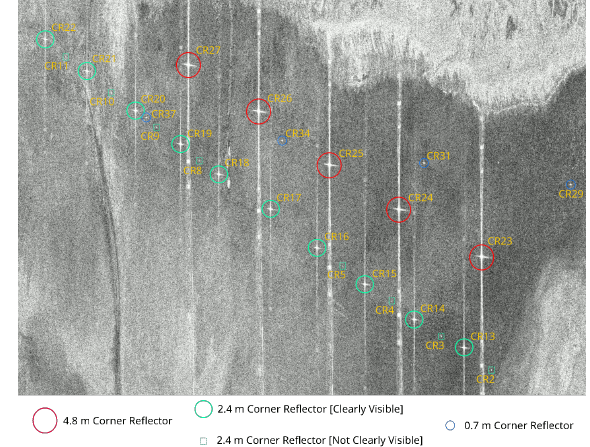
Figure 2. Intensity image of uncalibrated HH-band highlighting different corner